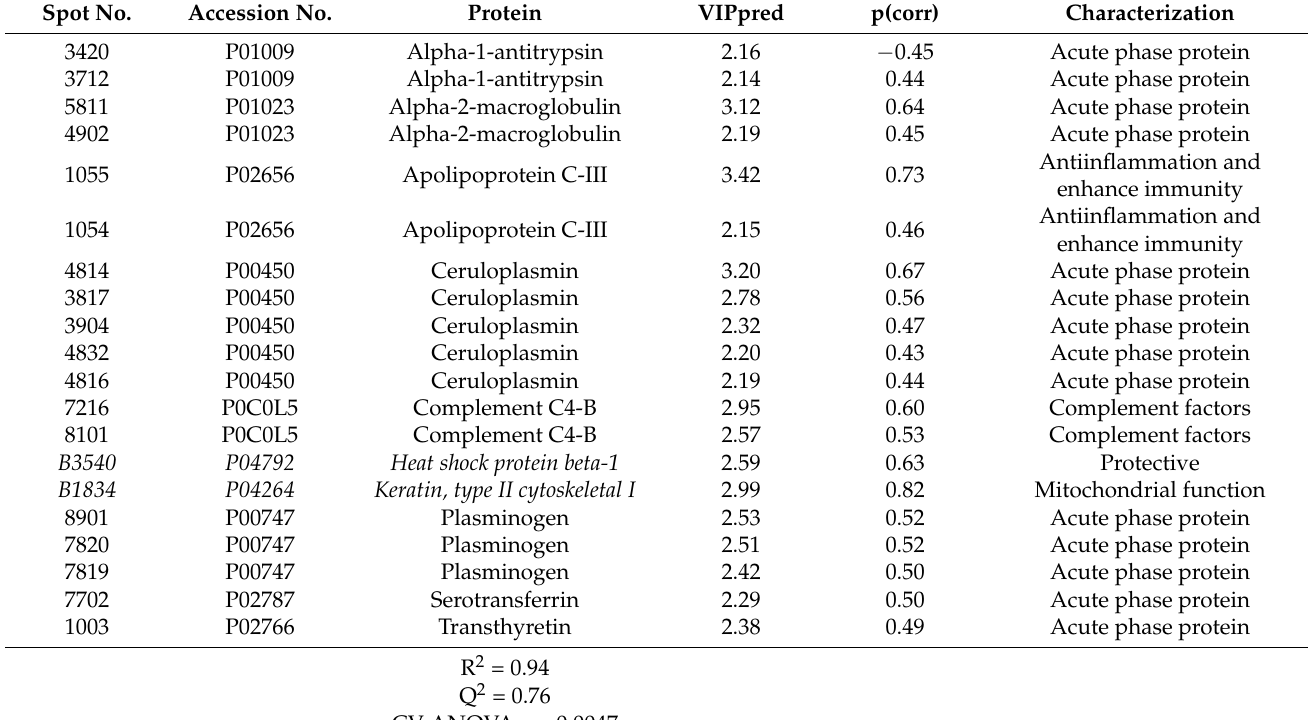
Table 2. OPLS regression of CPT in CON; significant proteins (in alphabetical order) are presented according to VIPpred. Characterization is based upon brief reviews presented in Text S2. Proteins in italics are from muscle biopsy and the others are plasma proteins. A positive sign of p(corr) indicates that a high level of the protein is associated with a low pain threshold for